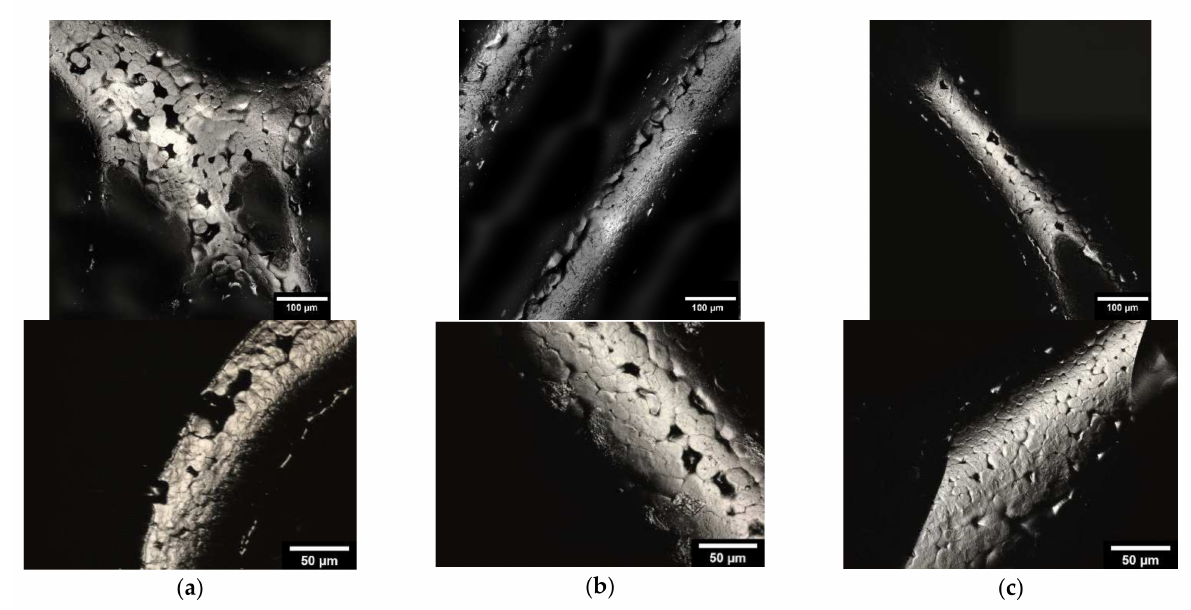
Figure 4. Comparison of the surface roughness for uncoated ( top ) and coated ( bottom ) PCL scaffolds, with variations in the infill structure ( a ): honeycomb; ( b ): wave; ( c ): line structure. Images were taken with a KEYENCE VK-X210 3D laser scanning microscope.